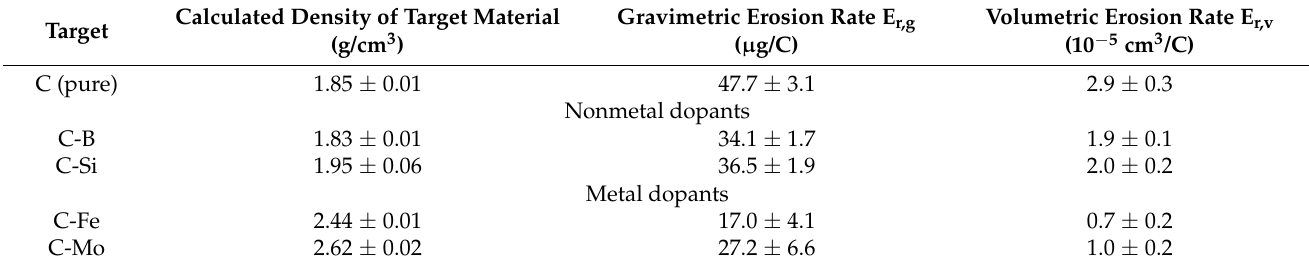
Table 4. Comparison of gravimetric and volumetric erosion rate and calculated density of target material for an evaporation current I = 1600